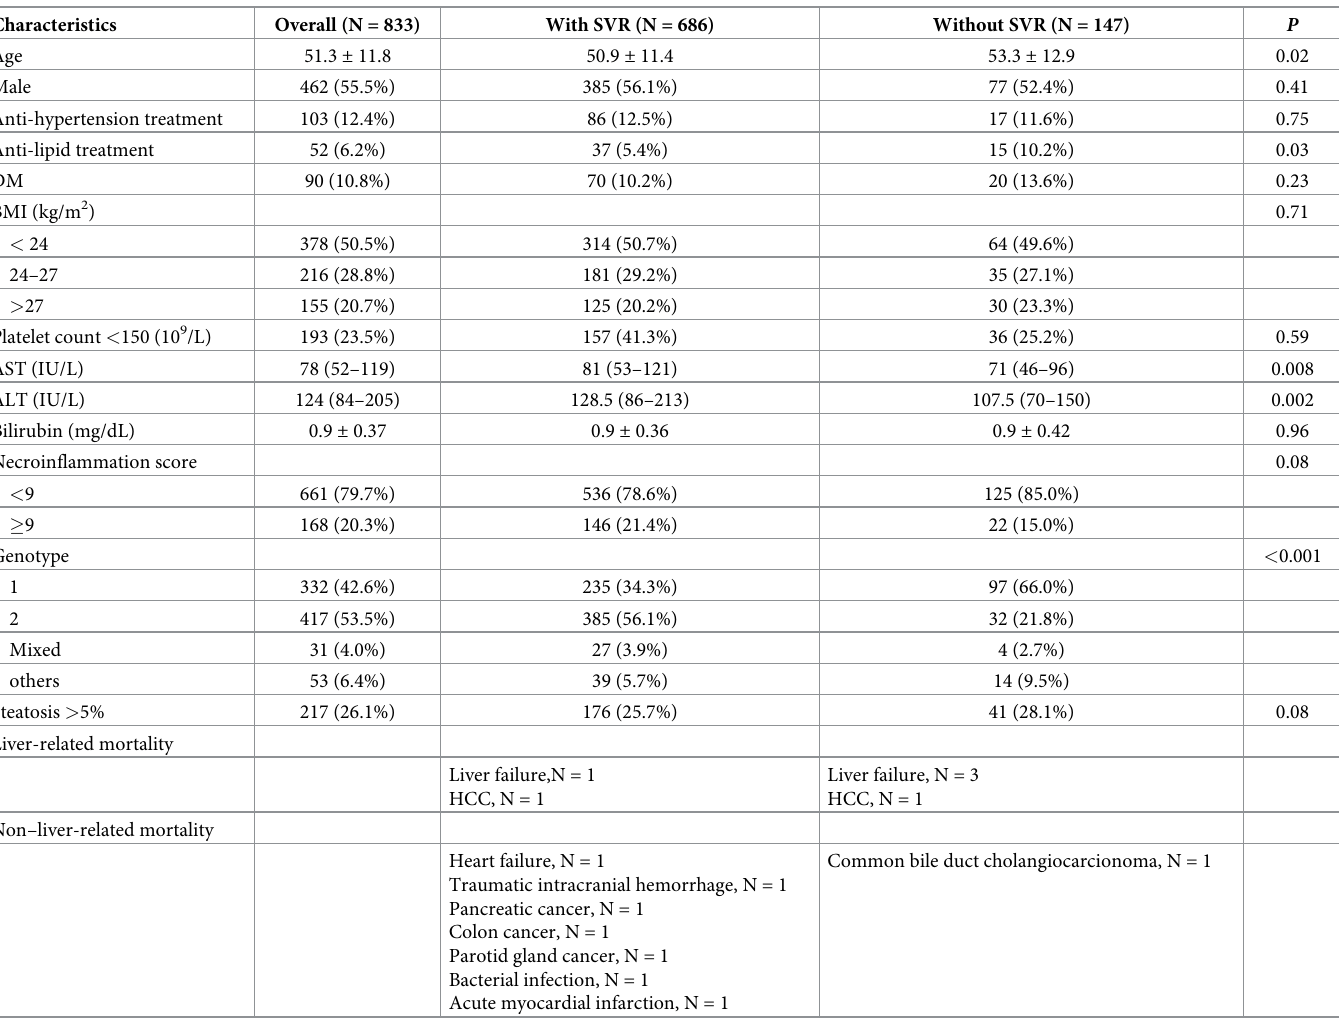
Table 3. Baseline Characteristics According to Treatment Response in mild fibrotic